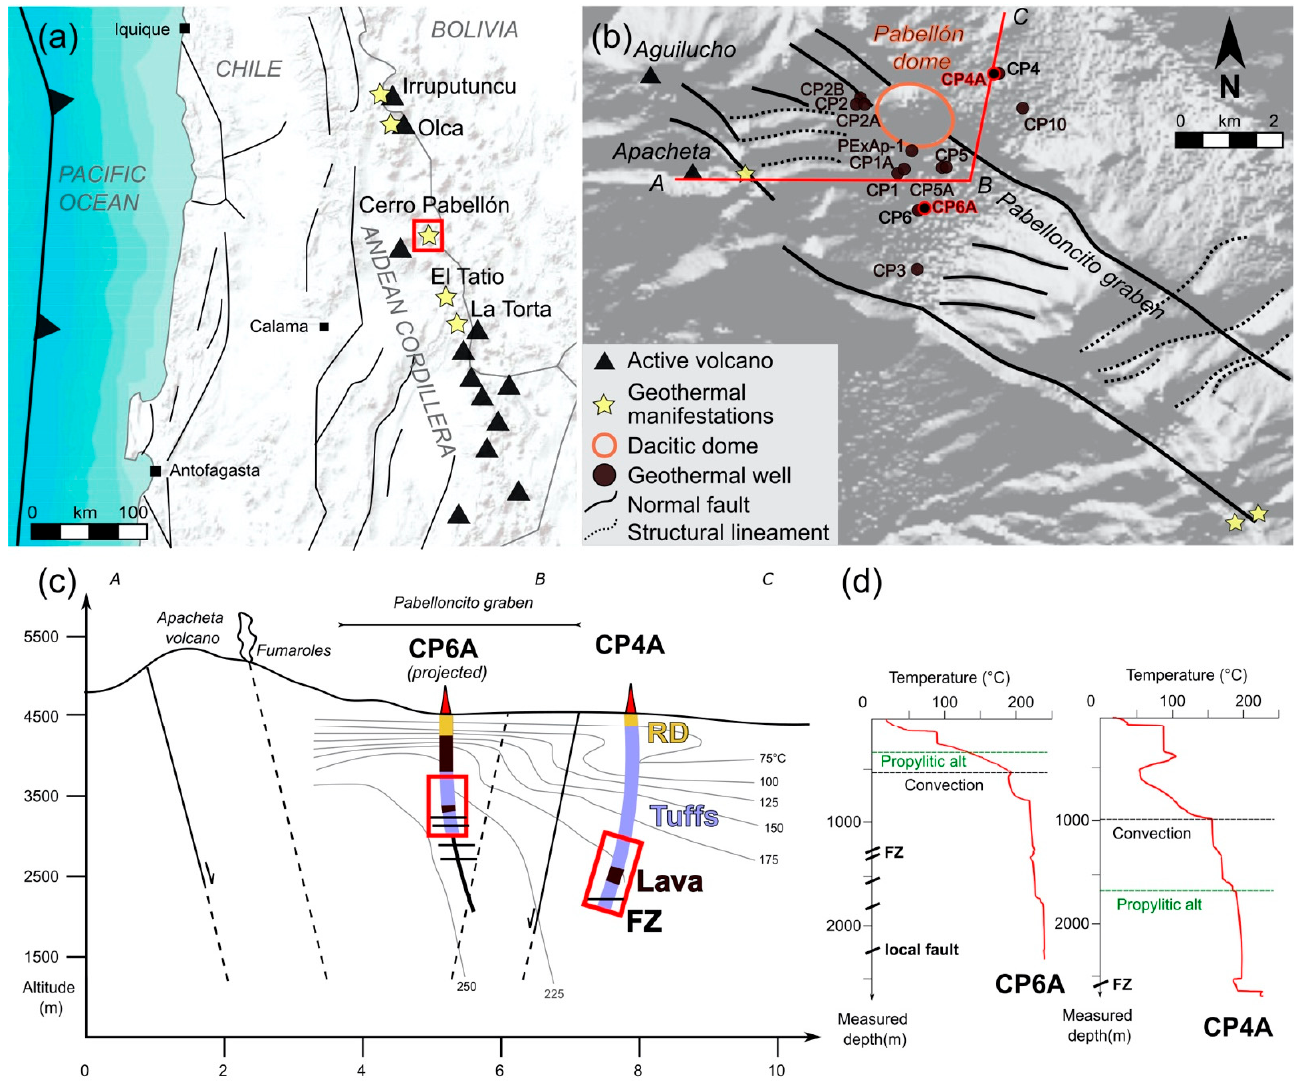
Figure 1. ( a ) Map of the Central Andean Volcanic Zone (CAVZ), regional scale faults, active volcanoes and main geothermal manifestations (geysers, fumaroles, steam grounds, hot springs, etc.) in the Chilean side after [1]. The image used in the background is from ESRI. The red square is the studied area, also detailed in ( b ): map of the Pabelloncito graben with geothermal wells, main faults and lineaments. The trace ABC in red is presented in ( c ): schematic profile with measured isotherms after [33]. The simplified geology and traces of the intersected fracture zones (FZ) and local faults are from [34] and [24]. The red rectangle is the studied zone in the paper. RD: recent deposits (unconsolidated deposits and ignimbrites); tuffs: lithic and dacitic tuffs; lava: andesitic lavas; red rectangles are the studied zone in this paper; the deep part of CP6A was not sampled because of circulation losses. ( d ) T profiles in CP4A and CP6A wells measured several months after drilling operations. FZ intersected and tops of convection and propylitic alteration are from [34].